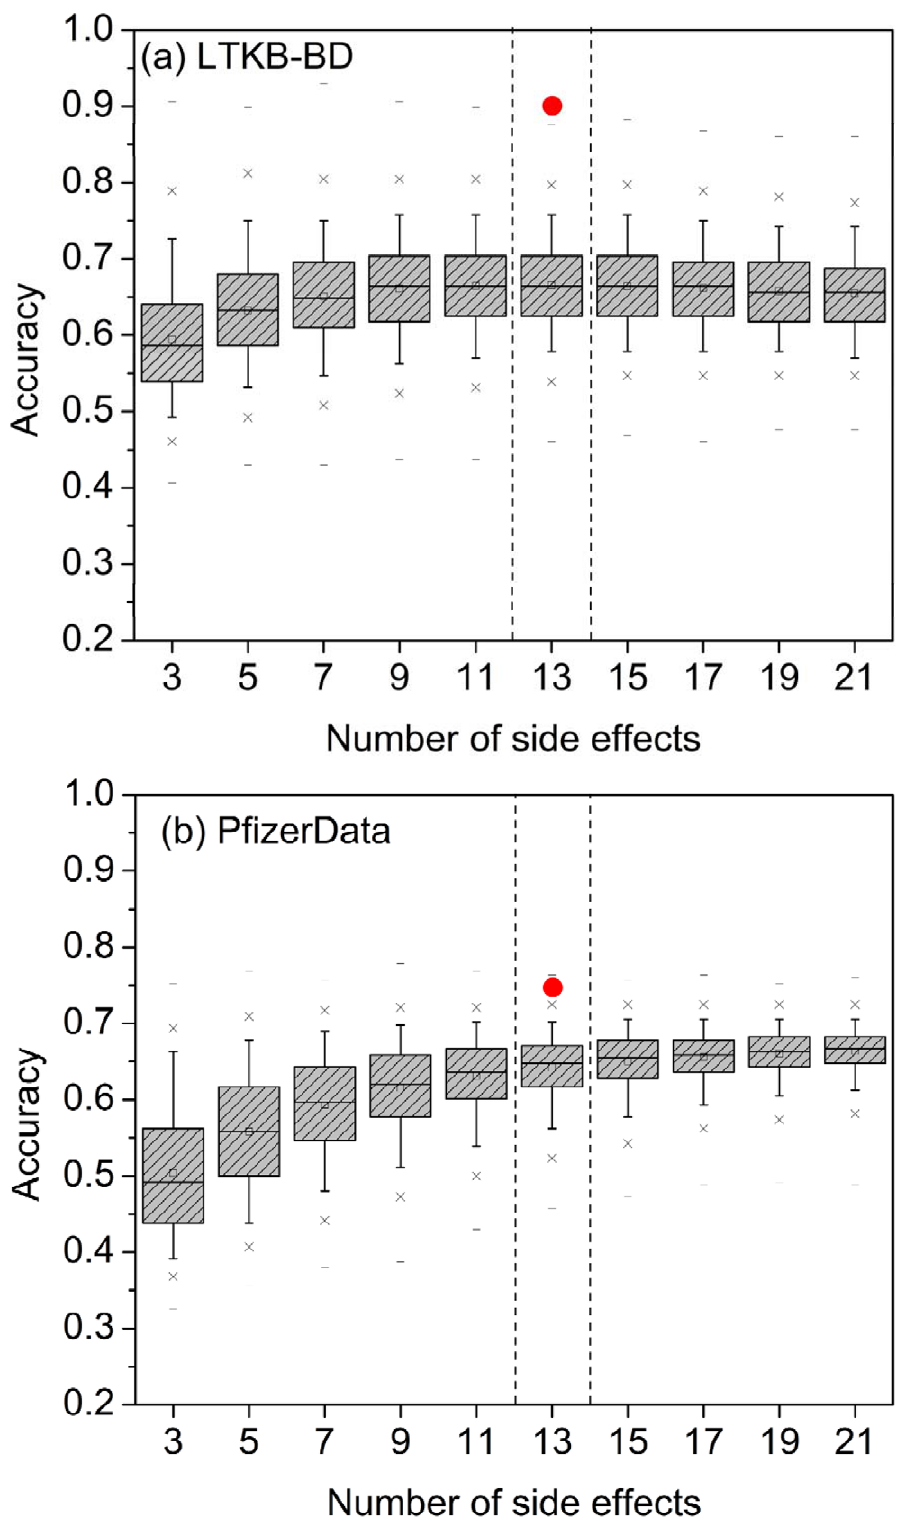
Figure 2. Box plot of classification accuracy with the number of selected side effects using a permutation test. (a) The test consisted of 128 drugs with a ratio of 69 DILI positives versus 59 DILI negatives in the LTKB-BD, and (b) 258 drugs with a ratio of 168 DILI positive drugs and 90 DILI negative drugs in PfizerData. Given a randomly selected number of side effects, a drug showing positive in any of the side effects was considered as a DILI positive drug. The process was repeated 20,000 times for each of the selected number of side effects. The red dot denotes the data based on the 13 HepSEs selected from the MedDRA hepatobilliary disorders category.